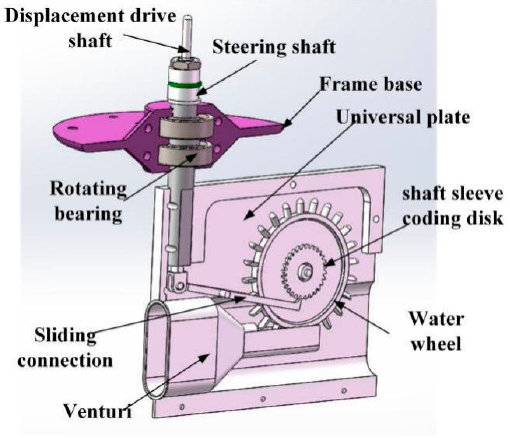
Figure 9. Principle of velocity measurement.